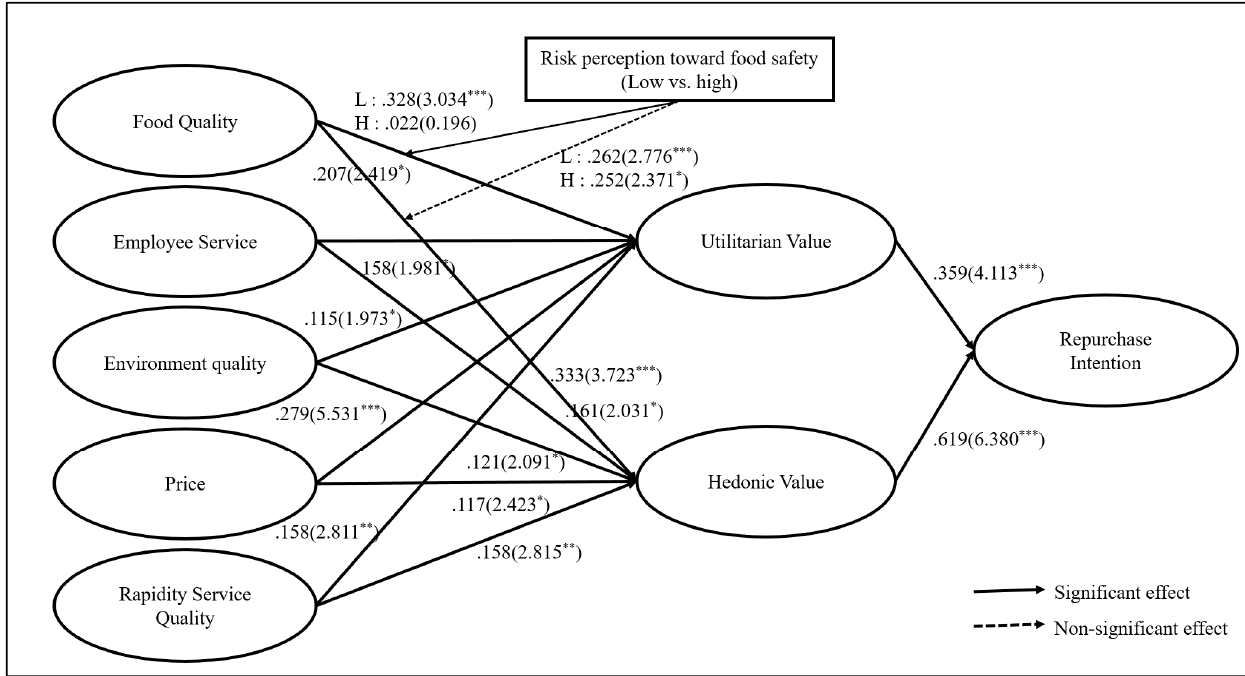
Figure 1. Structural equation model with parameter estimates. Note: standard coefficient (t value) * p < 0.05, ** p < 0.01, *** p < 0.001.